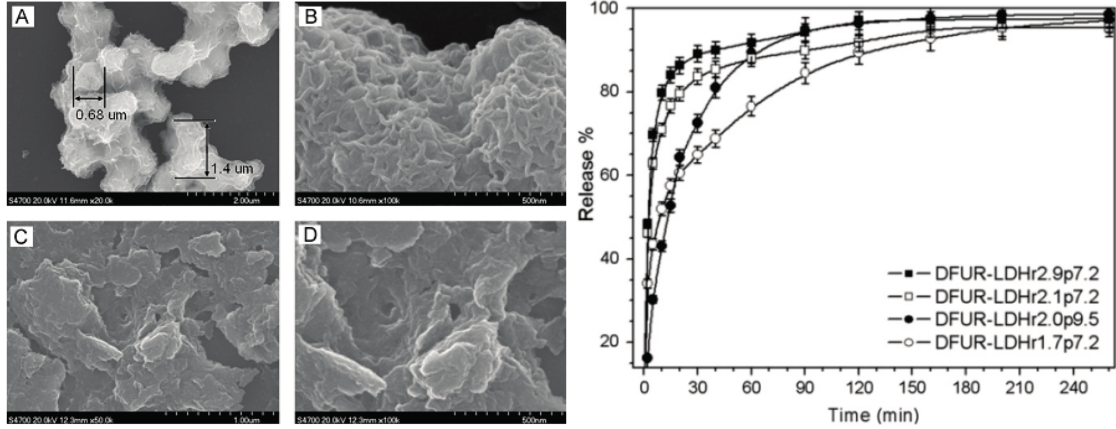
Figure 17. ( Left ) SEM images of DFUR–LDH r 1.7 p 7.2 ( A , B ) and DFUR–LDH r 2.0 p